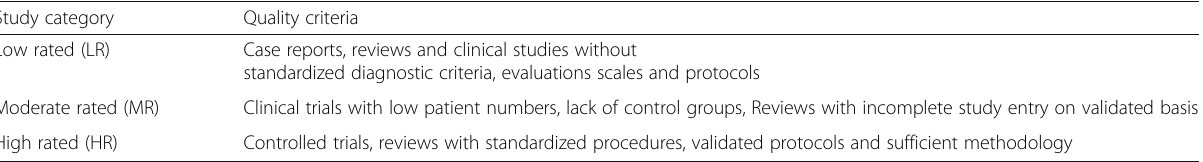
Table 1 Study selection